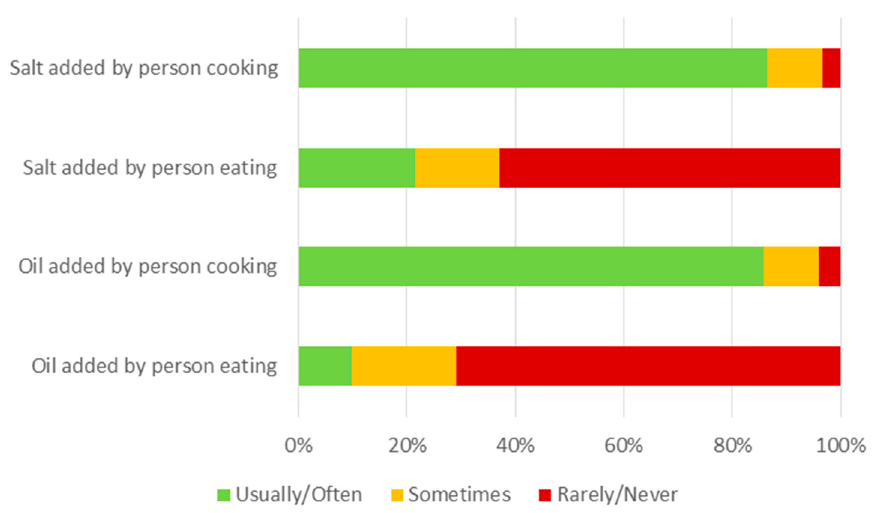
Figure 5. Frequency of adding salt and oil to food by participants and household cooks. Table 7. Associations between sociodemographic characteristics and high home salt consumption among the study population.